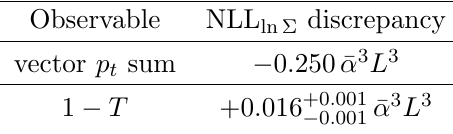
Table 1 . Corrected NLL di(cid:11)erences between the Pythia and Dire shower-algorithm results and the analytic resummation for di(cid:11)erent observables, at the (cid:12)rst non-trivial perturbative order in (cid:22) (cid:11)L = 2 C F (cid:11) s L=(cid:25) , with L = ln 1 =v , for the thrust and vector p t sum. The uncertainty in the thrust case corresponds to a statistical integration error, while the vector p t sum has obtained semi-analytically.